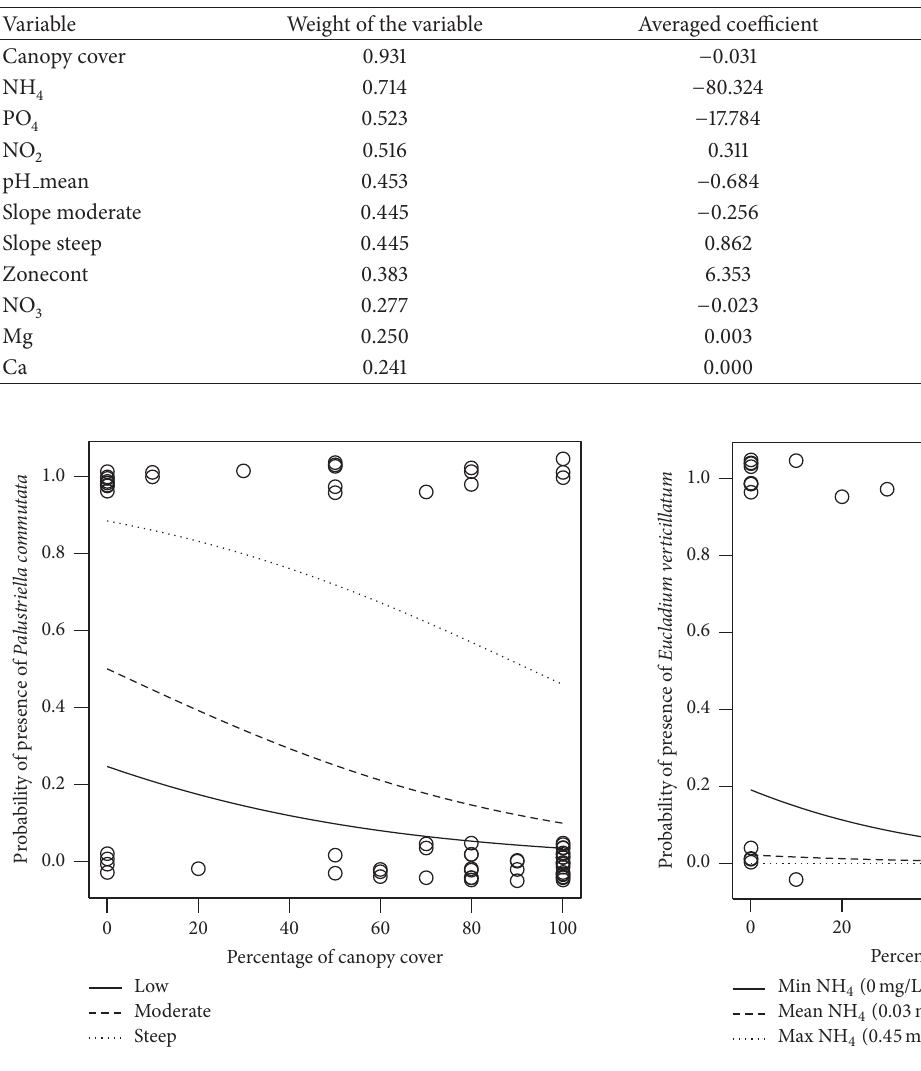
Figure 6: Prediction of presence of Eucladium verticillatum in relation to canopy cover based on the coefficients of the best models selected by AIC stepwise selection for different levels of NH 4 : maxi- mum concentration in the dataset (dotted line), mean concentration in the dataset (dashed line), and minimum concentration in the dataset (solid